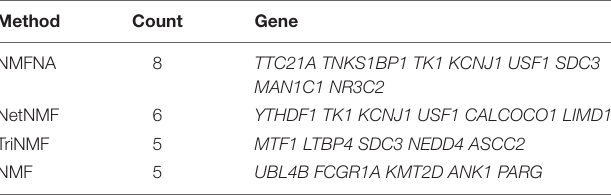
TABLE 5 | PC-related genes in the top 10 characteristic genes of both ME and CNV core modules. Method